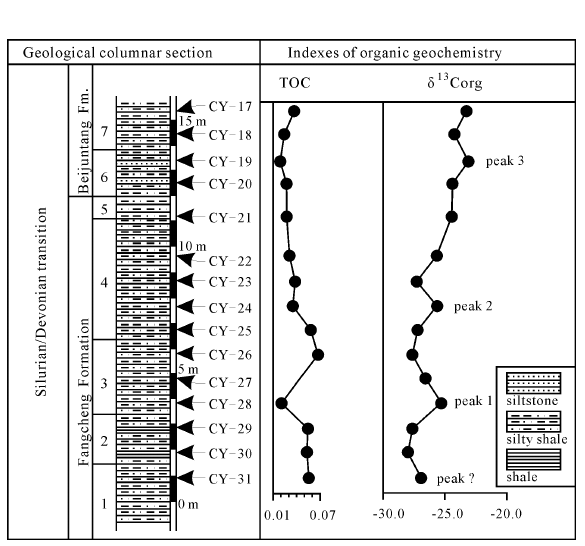
Fig. 2. Stratigraphic succession, total organic carbon content and stable isotopic ratio of organic carbon versus depth in the Changwantang